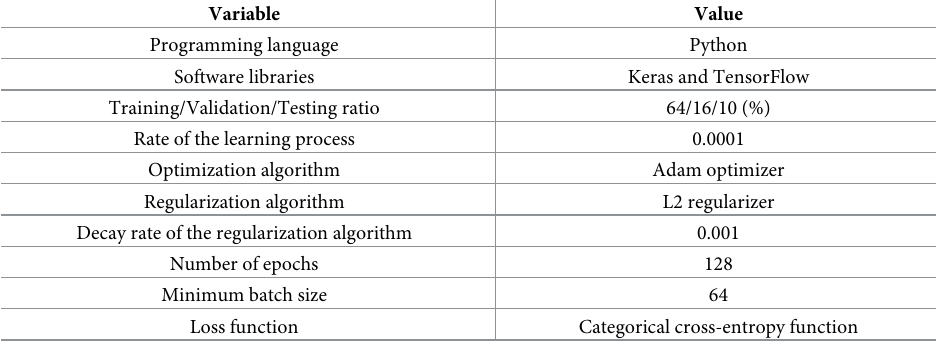
Table 3. Simulation specifications of the examined CNN algorithms in the proposed comprehensive